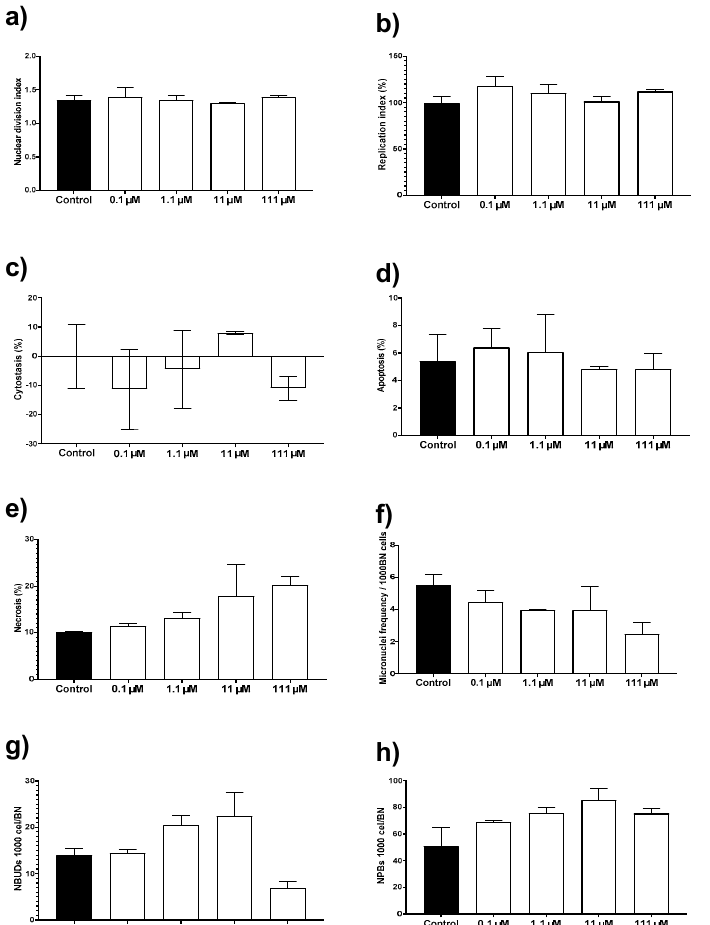
Figure 5. Evaluation of cytotoxic and genotoxic effects of different concentrations of AgNPs on human peripheral blood lymphocytes (HPBL). HPBL were exposed to 0.1, 1.1, 11, and 111 µ M (0.012, 0.12, 1.2, and 12 µ g/mL) following the cytokinesis-block micronucleus (CBMN) assay registering the biomarkers ( a ) nuclear division index; ( b ) replication index; ( c ) cytostasis; ( d ) apoptosis; ( e ) necrosis;